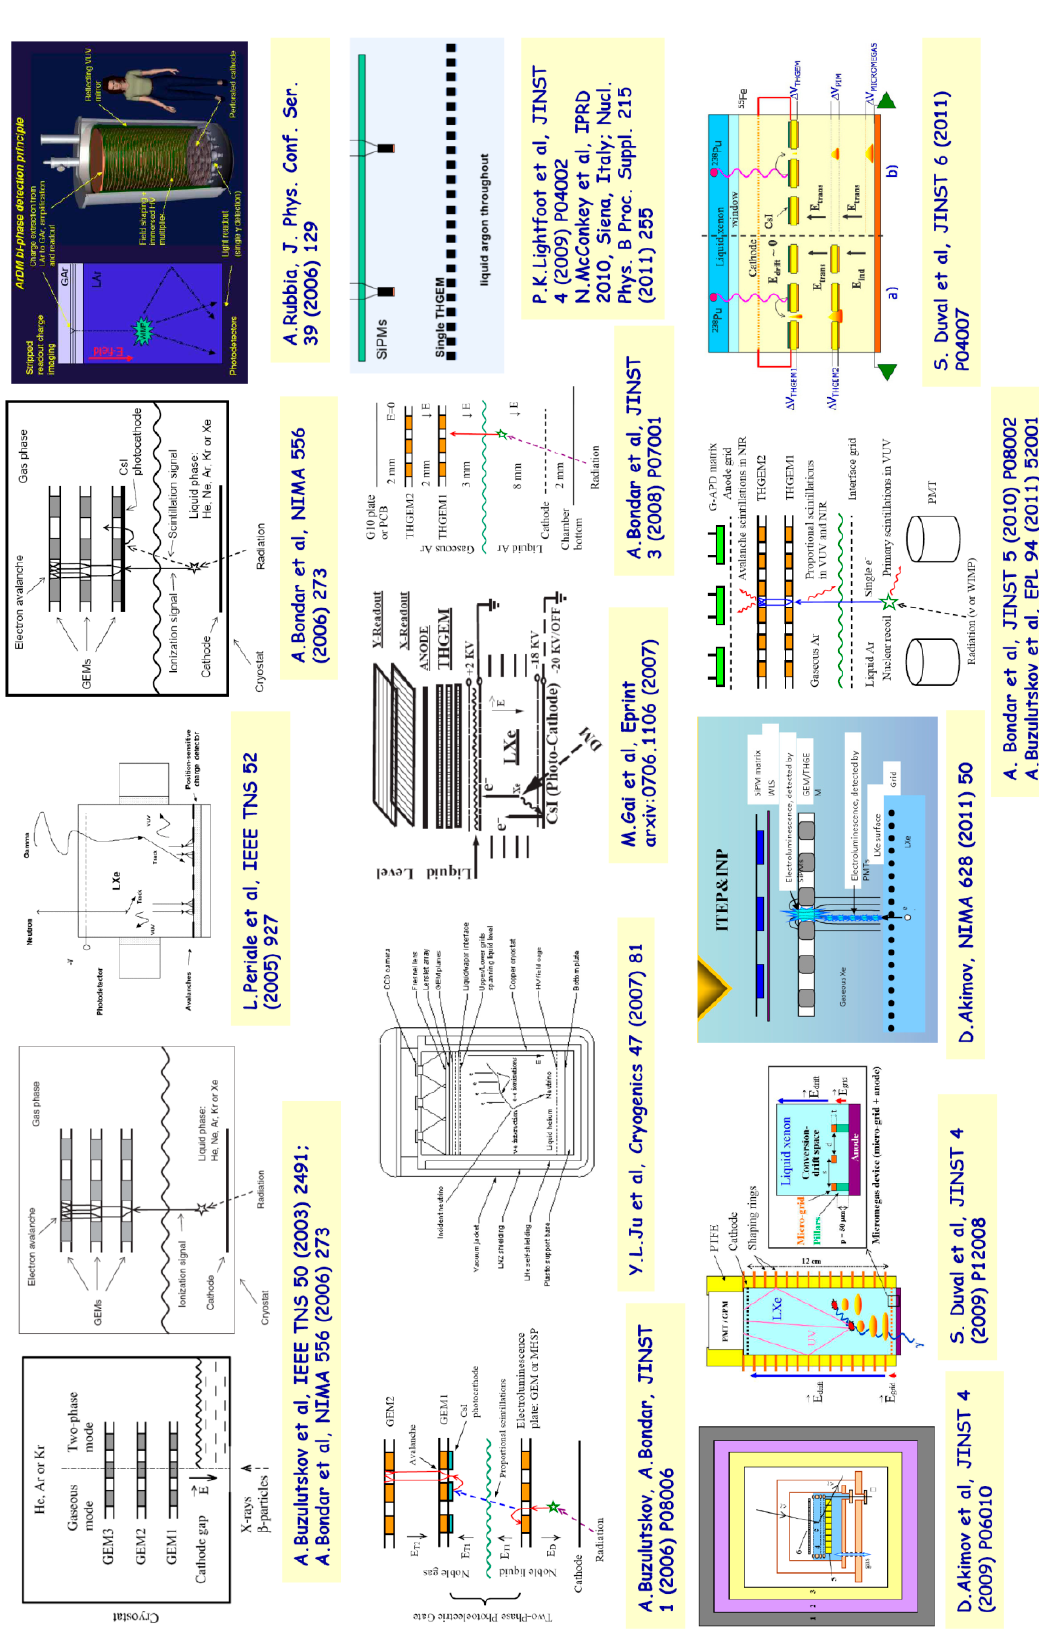
Figure 13. Gallery of concepts of charge signal amplification in two-phase detectors, using electron avalanching in the gas phase and charge or optical readout, by 2012 in order of introduction.